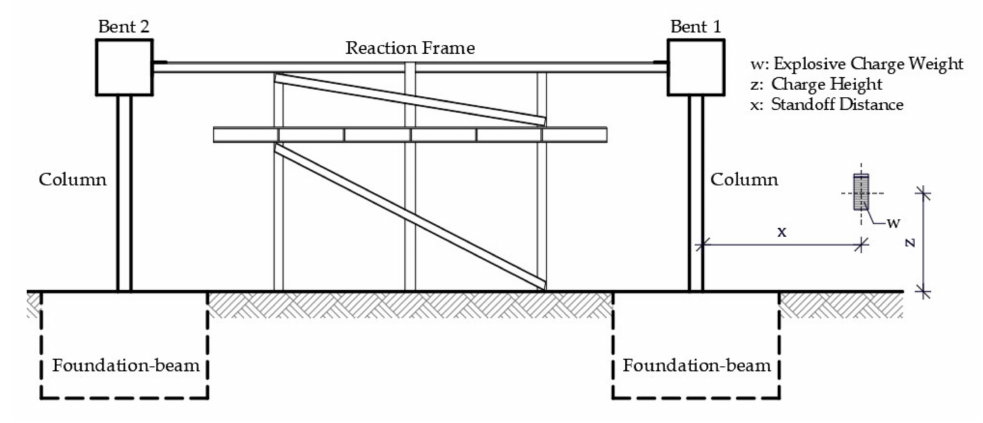
Figure 3. Test setup in [7] and [9].